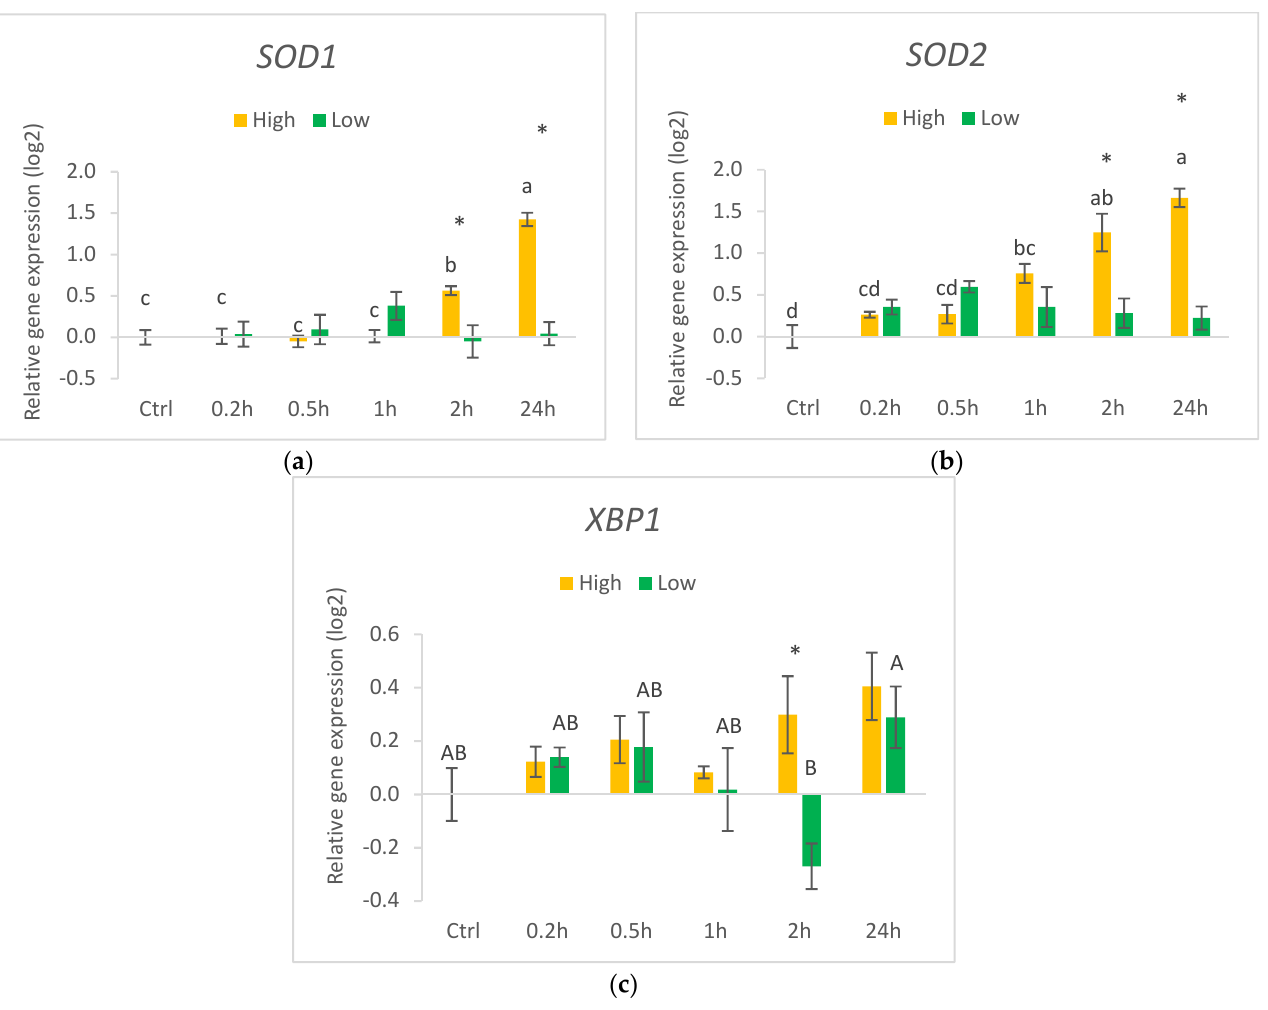
Figure 7. Relative gene expression of markers for antioxidant defence ( a ) SOD1, ( b ) SOD2 and ER stress ( c ) XBP1 in HT29 cells exposed to high (140 µM) or low (0.014 µM) concentrations of HHE in growth media. Data (n = 4) are means shown with standard error mean. Significant differences between control (Ctrl) and different time points within Low or High are indicated with different letters (High: lower letters, Low: capitalised letters) evaluated with Tukey–HSD ( p < 0.05). Significant differences between Low and High are evaluated by Student’s t -test and indicated with asterisk (*) at specific time points.